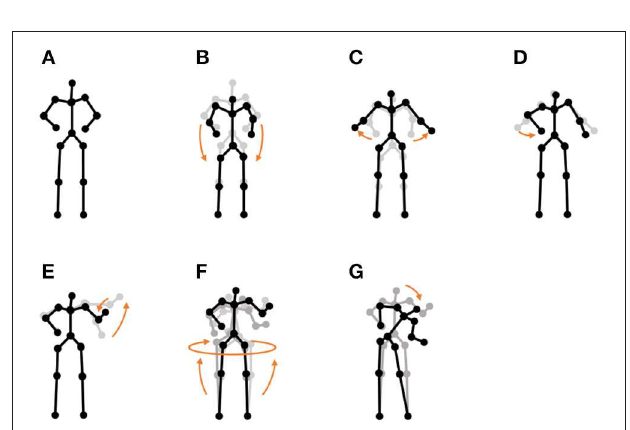
FIGURE 11 | Seven unit motions included in the “I’m a little teapot” dance: (A) short and stout, (B) bending knee, (C) spread arms, (D) handle, (E) spout, (F) steam up, and (G) pour.